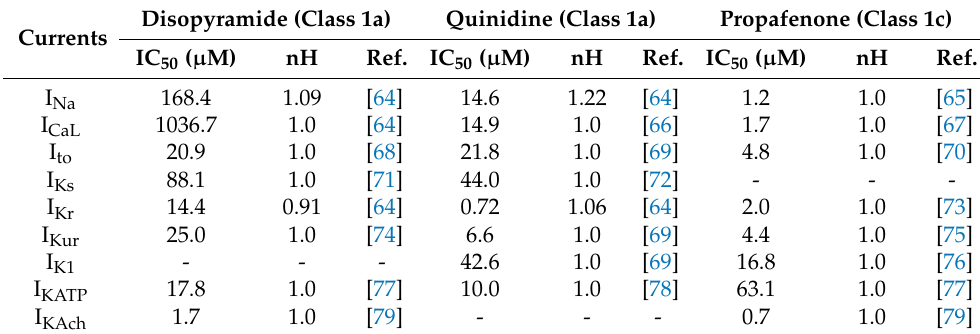
Table 4. Parameters associated with blocking effects of antiarrhythmic